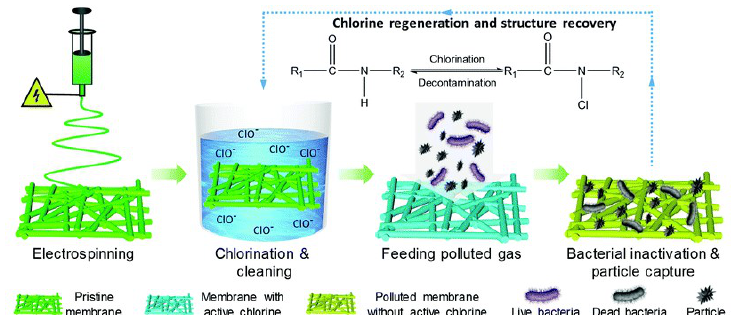
Figure 14. Schematic illustration of the design process of the versatile NFMs with rechargeable biocidal capacity and renewable air filtration performance. Reused under the terms of the